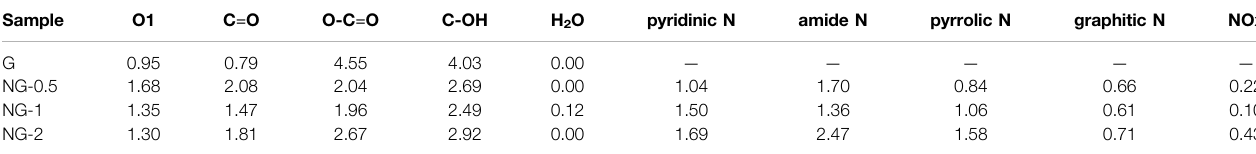
TABLE 1 | Content of different O and N species in graphene monolith samples from XPS and corresponding deconvolution results.